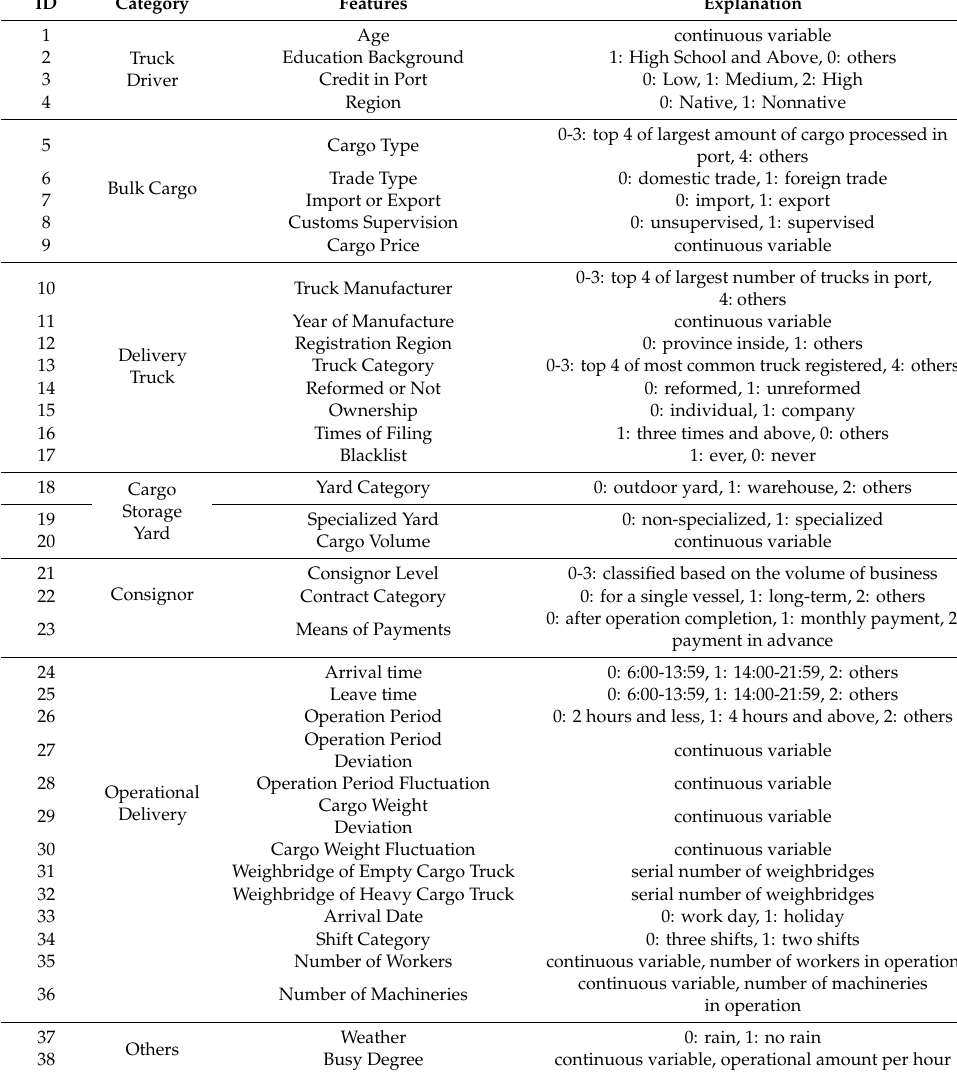
Table 2. Relevant elements of fraud risk on bulk cargo theft in